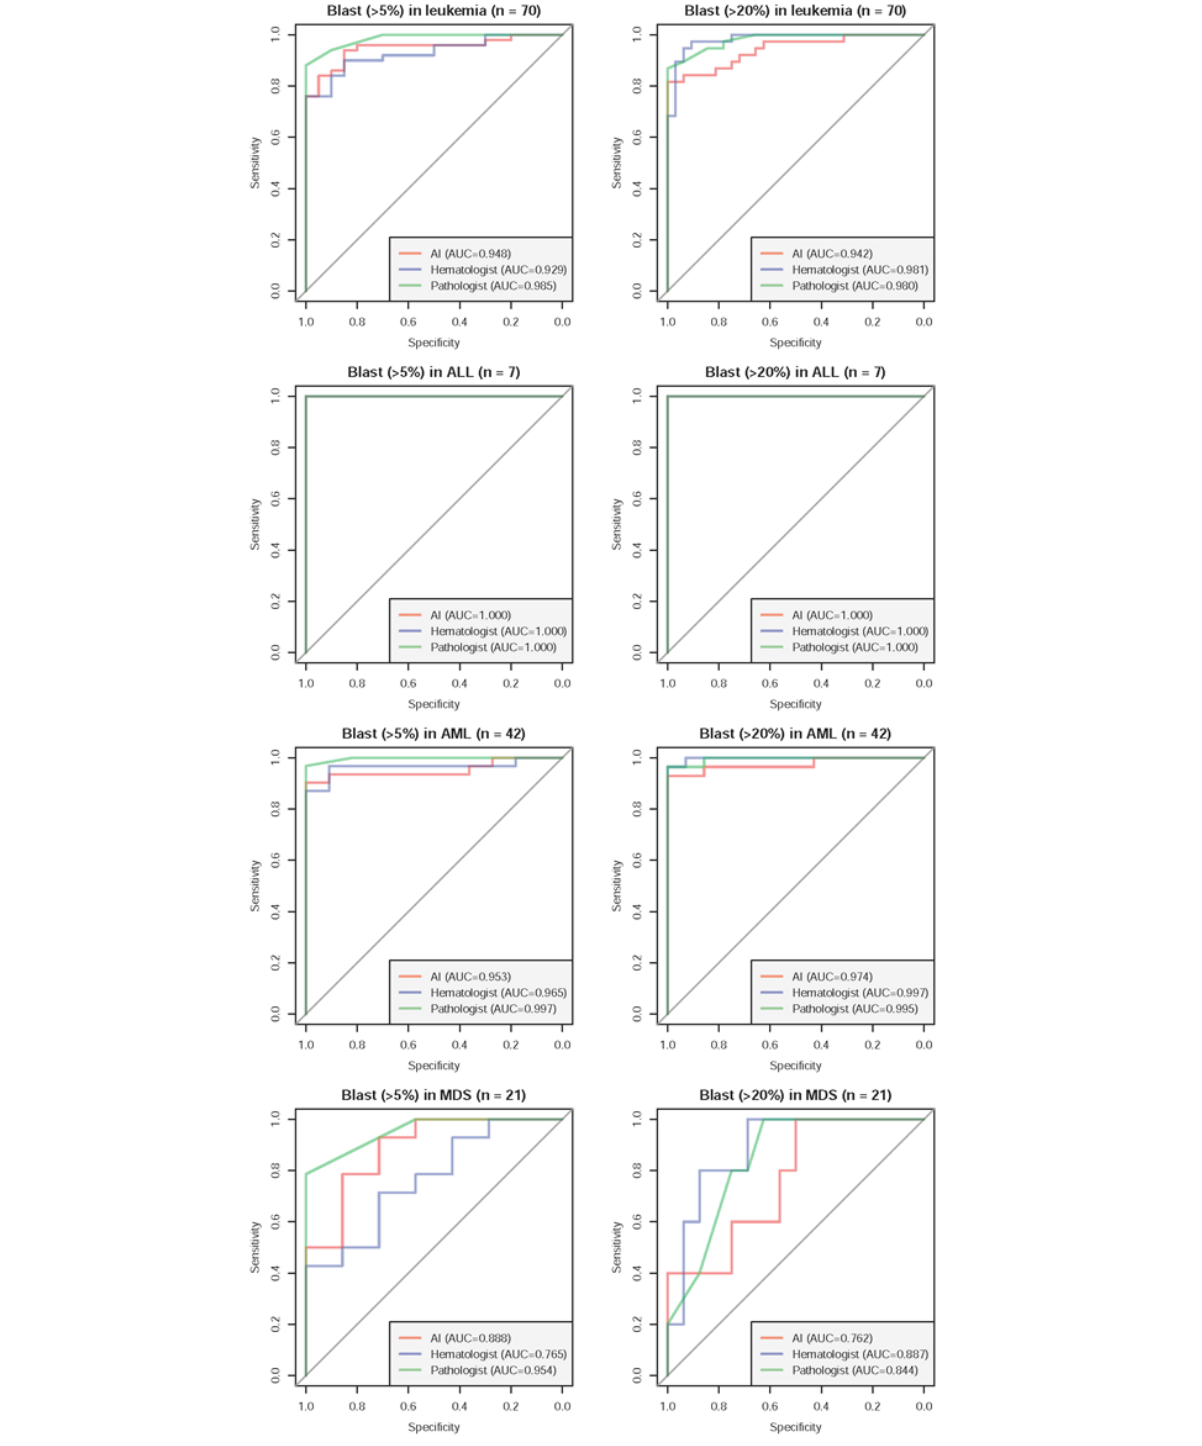
Figure 6. Receiver operating characteristic (ROC) curves in the diagnosis of acute leukemia and myelodysplastic syndrome in the validation cohort (n=70). The ROC curves correspond to the blast proportions that were obtained by BMSNet, the hematologists, and the pathologists. The outcome value is defined as more than 5%/20% blasts via flow cytometry. AI: artificial intelligence; ALL: acute lymphoblastic leukemia; AML: acute myeloid